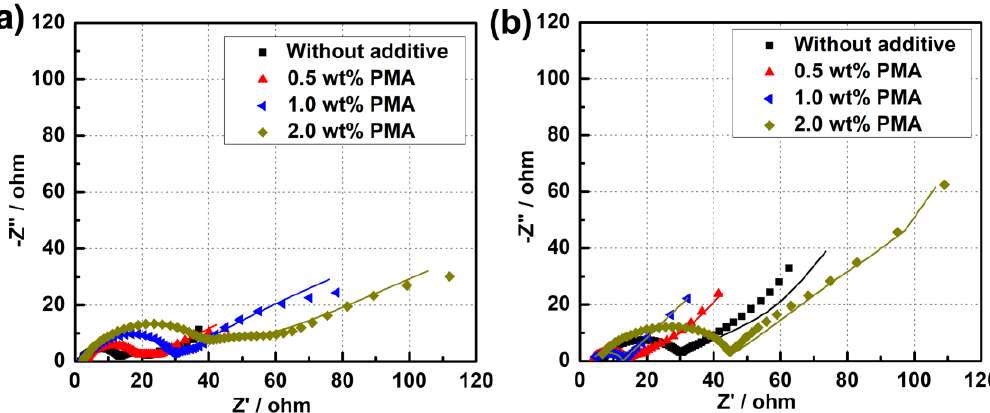
Figure 8. SIMS depth profile of the MCMB electrode with additive-free electrolyte and different concentrations of PMA added electrolyte at 55  C. ( a ) additive-free electrolyte, ( b ) 0.5 wt.% ( c ) 1.0 wt.% and ( d ) 2.0 wt.% of PMA additive .